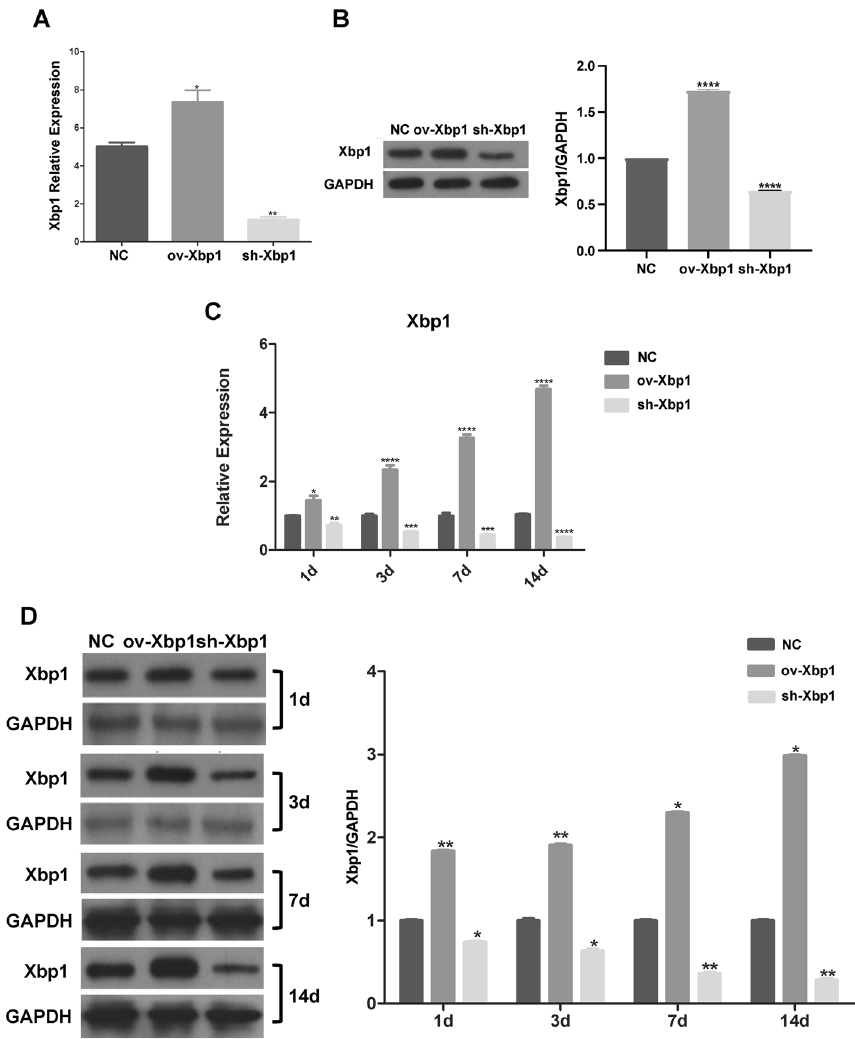
( D ) results of the overexpressed Xbp1 and Xbp1-knockdown rat models. Student’s t -tests were conducted. * P < 0.05, ** P < 0.01, *** P < 0.001, **** P < 0.0001 compared with the